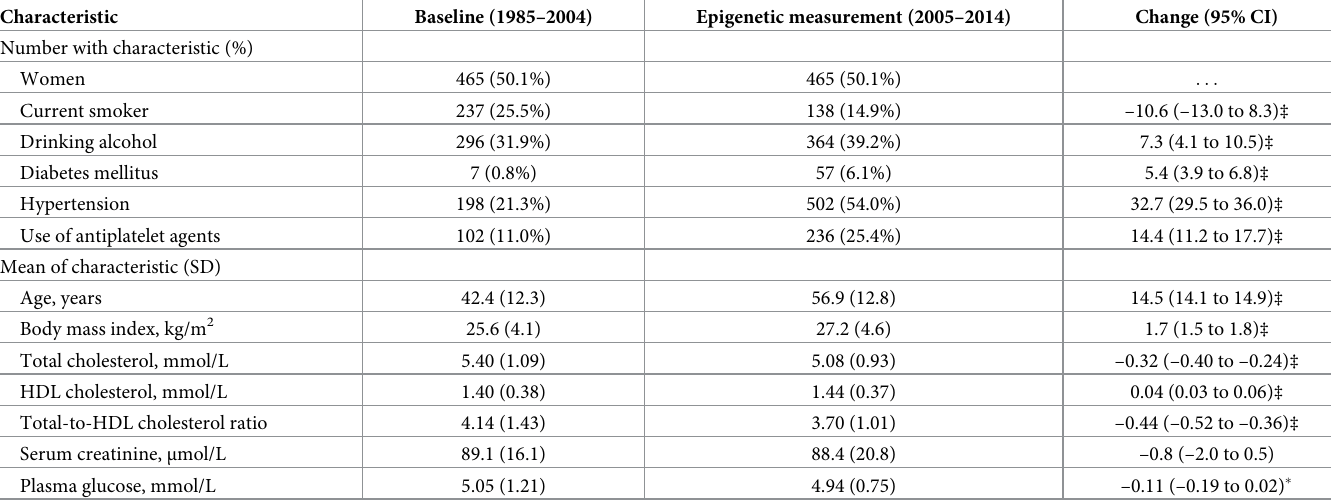
Table 2. Characteristics of 929 participants at baseline and at the time of the epigenetic measurements.